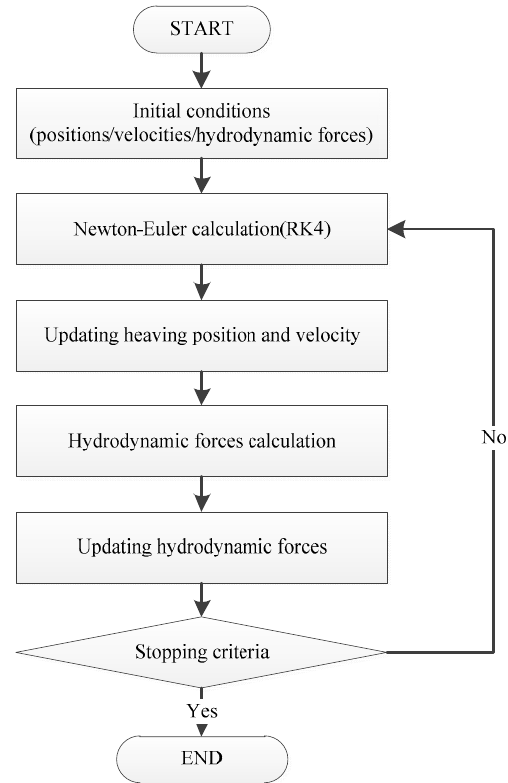
Figure 4. Flow chart of the dynamic-hydrodynamic coupling method for semi-active flapping foil.